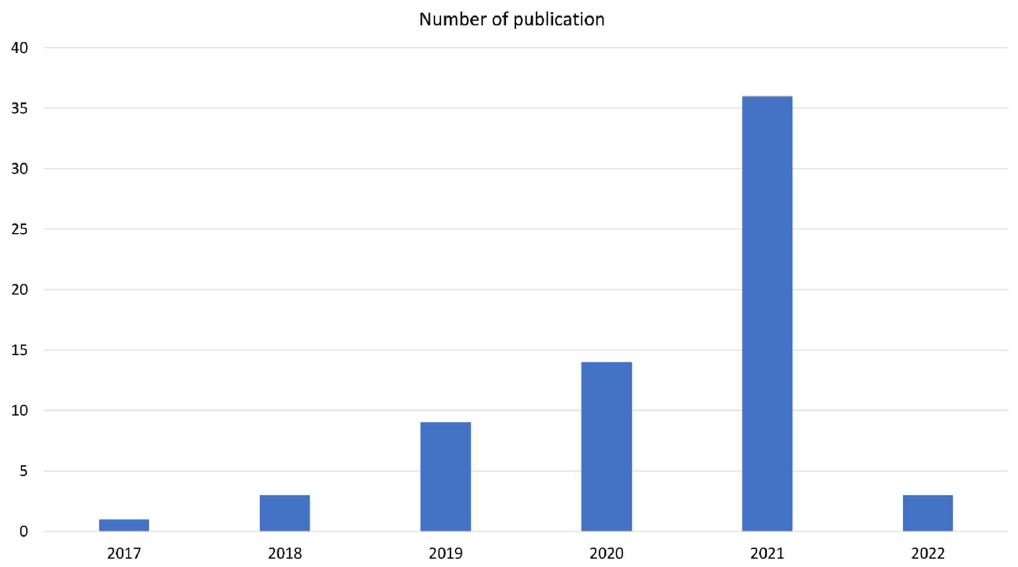
Figure 3. Yearly publication trend from 2017–January 2022. Table 2. Number of publications by year and journal outlets (Data retrieved from Web of Science core collection database from 2017–January 2022).